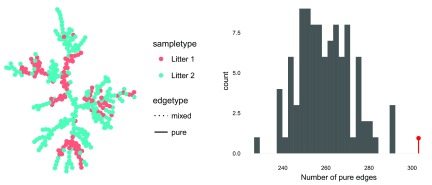
The graph and permutation histogram obtained from the minimal spanning tree with Jaccard similarity.